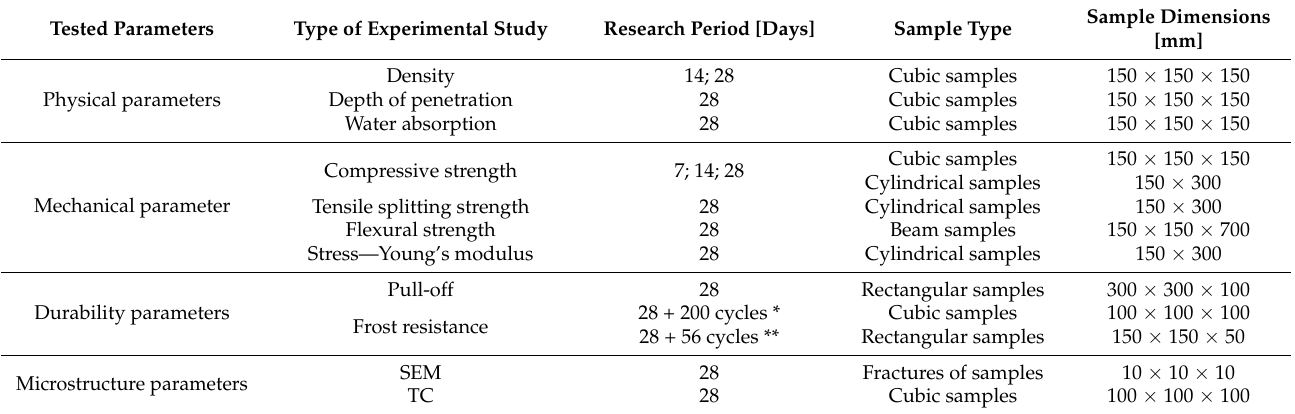
Table 7. List of parameters of hardened concrete samples intended for testing.